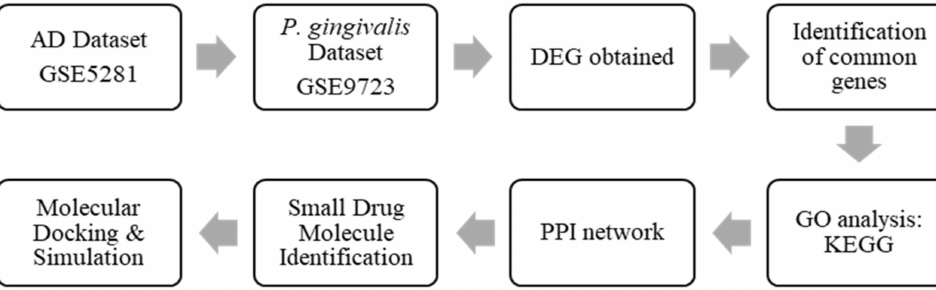
Figure 9. Flow chart of this